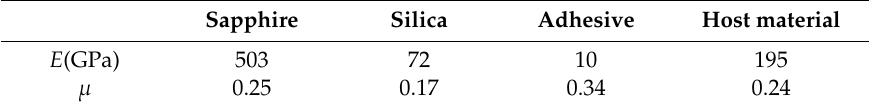
Table 1. Physical characteristics of materials used in strain-transfer model.